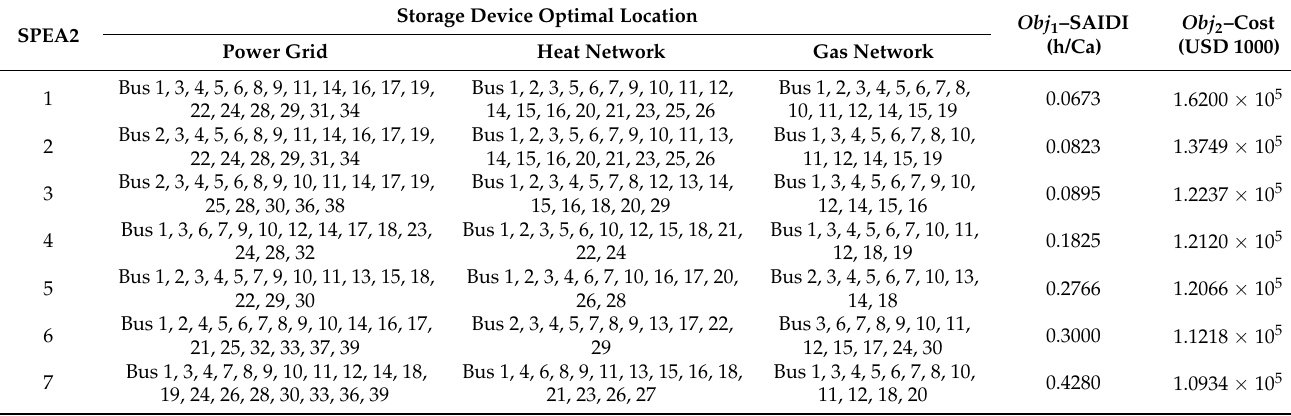
Table 9. SPEA2 optimization